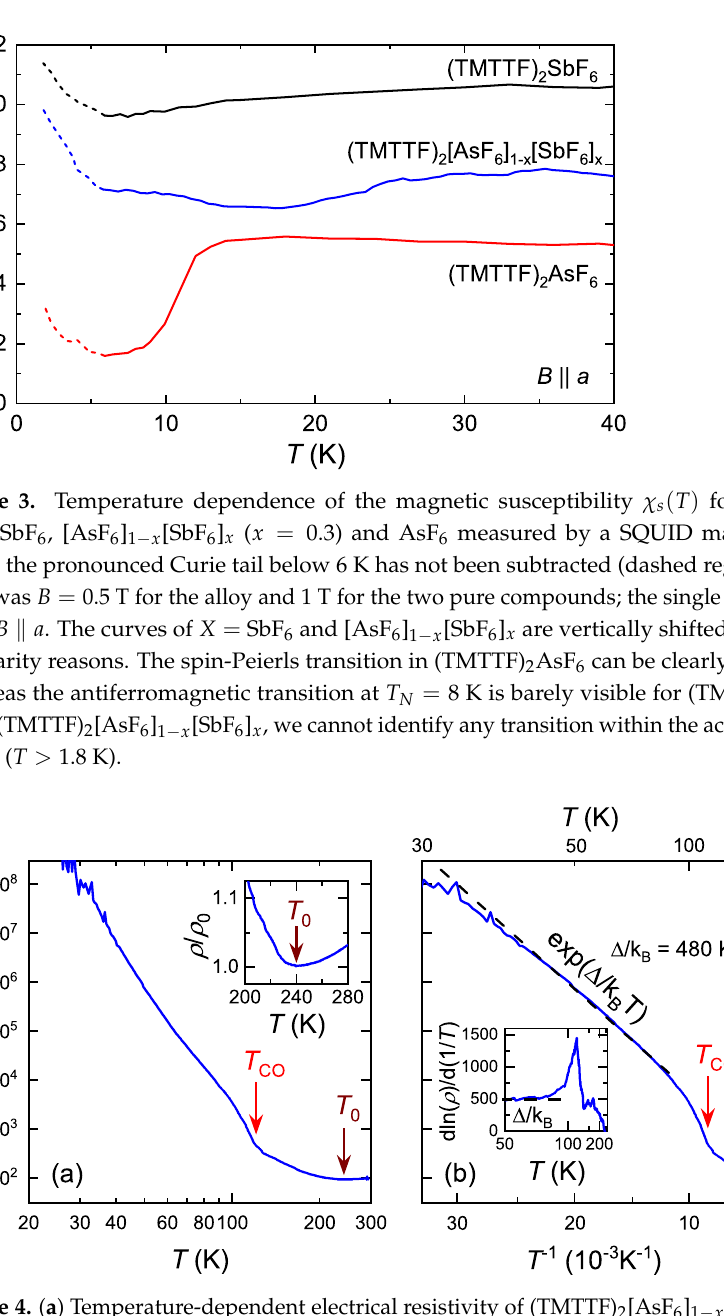
Figure 4. ( a ) Temperature-dependent electrical resistivity of (TMTTF) 2 [AsF 6 ] 1 − x [SbF 6 ] x with x = 0.3 (electrical current parallel to a -axis) measured in situ during optical reflection measurements in the ac -plane. The sharp increase at T CO = 120 K indicates the CO transition. The localization temperature T 0 = 240 K is a little lower compared to the parent compounds (TMTTF) 2 AsF 6 and (TMTTF) 2 SbF 6 [37], but otherwise the transport properties are qualitatively similar. ( b ) The Arrhenius plot yields an approximately constant energy gap ∆ / k B = 480 K in the temperature range 40–100 K, as illustrated in the transport derivative d ln ρ / d ( 1/ T ) in the